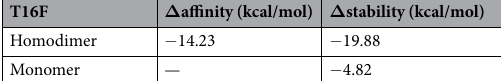
Table 2. In silico mutagenesis and affinity/stability analysis and calculations. Δ affinity values report the change in binding affinity within protomers between the wild type and Vb TA T16F mutant; Δ stability values report the changes in protein (monomer or homodimer) stability occurring after the mutation; stability is defined as the difference in energy between the folded and unfolded states. Δ affinity and Δ stability data are calculated using an implicit solvent MM-GBSA